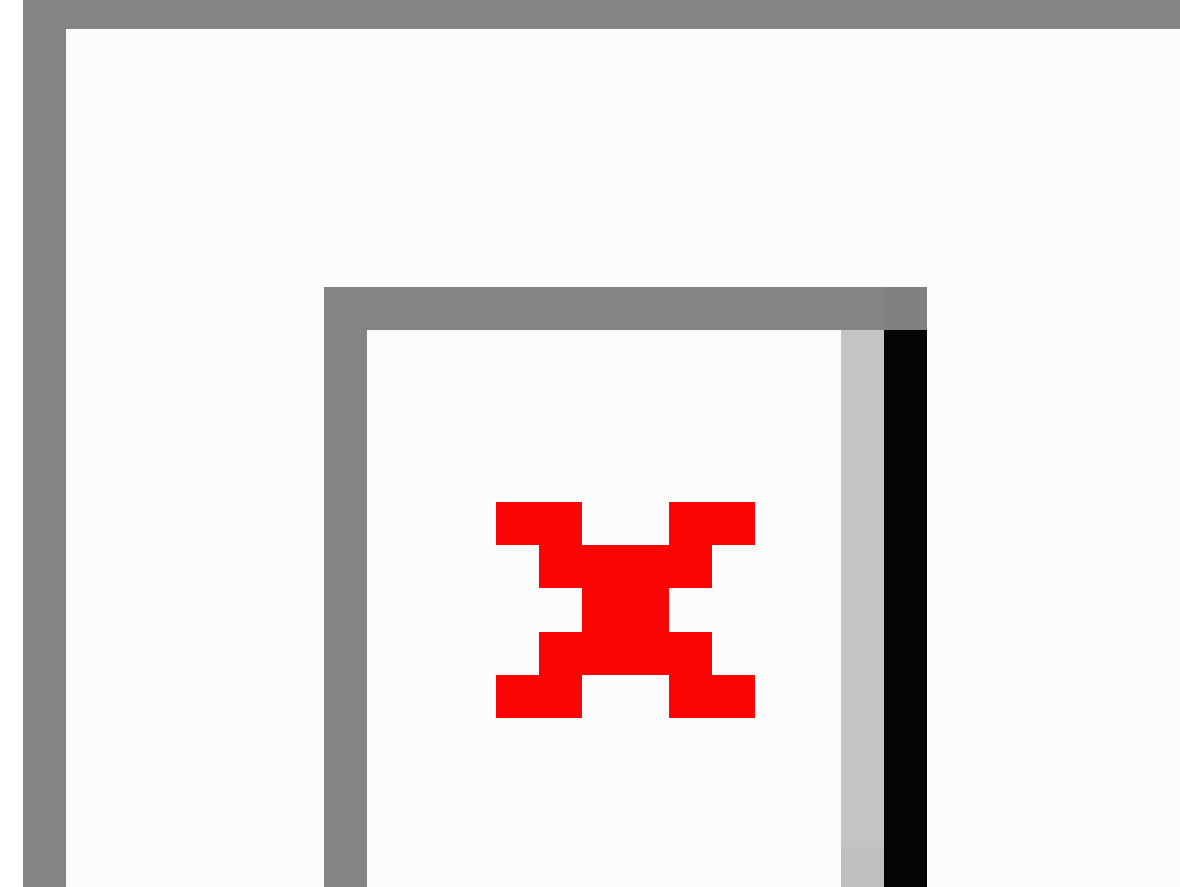
Figure 8. Sadness decreases dramatically in the second half of the study for Theresa, coinciding with her successful negotiation of conflict at home and